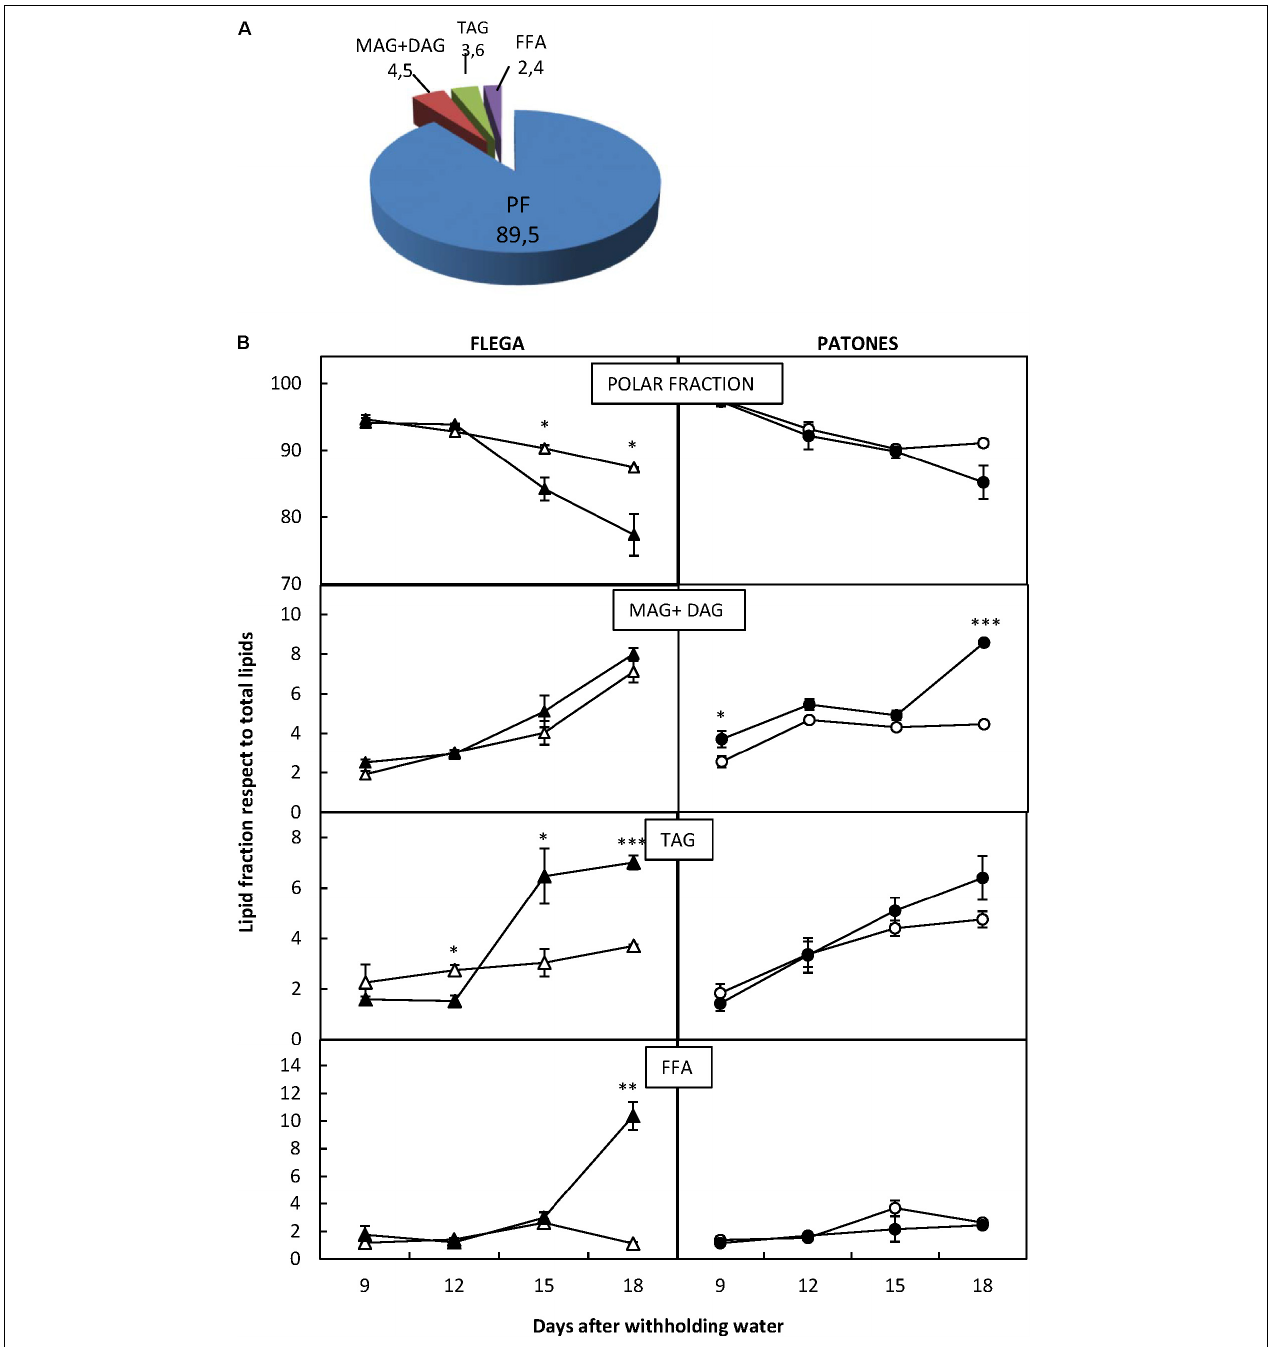
FIGURE 2 | Lipid fractions. (A) Lipid fraction distribution. Total lipids were separated cromatographycally in four lipid fractions: polar (PF), mono and di-acylglicerides (MAG + DAG), triacylglicerides (TAG) and free fatty acids (FFA) and their proportions calculated. (B) Lipid Fraction dynamic over a drought time course. Each lipid fraction was quantified in drought susceptible Flega (triangles) and resistant Patones (circles) well-watered plants (open symbols) and during a time course of water stress (solid symbols) (9, 12, 15, and 18 days). Data are mean of five replicates ± standard error. ∗ , ∗∗ , and ∗∗∗ indicate significant differences at P < 0.05, 0.01, and 0.001,